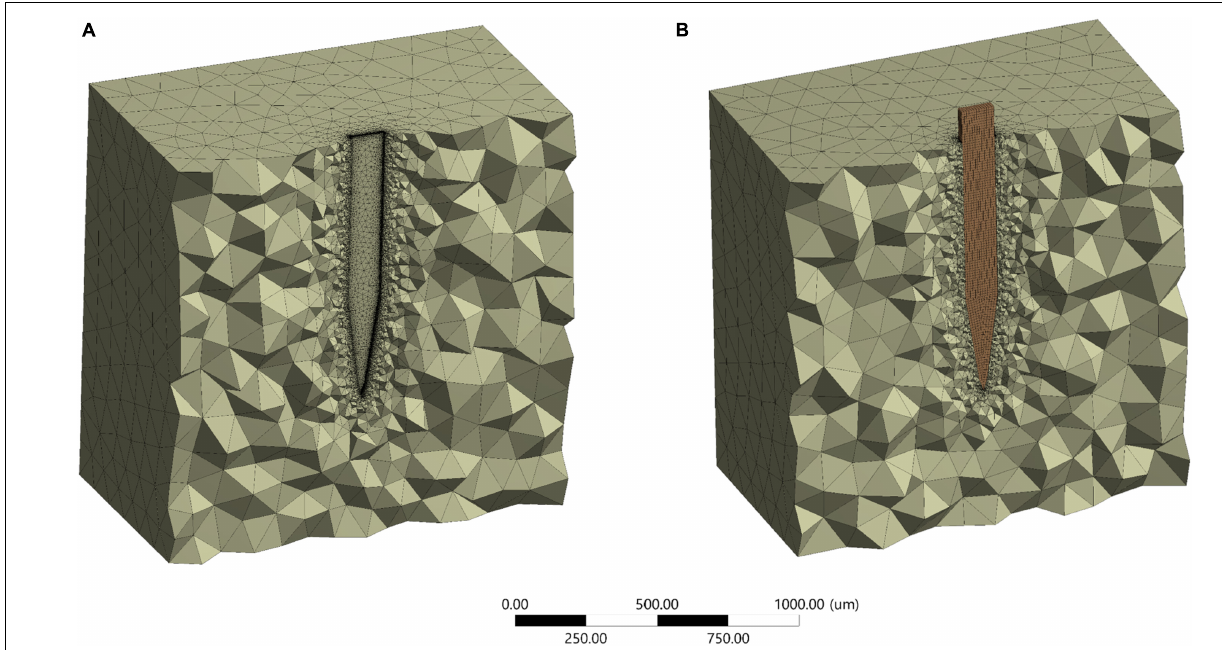
FIGURE 6 | Final mesh half-section view. (A) Without probe; (B) with a probe.